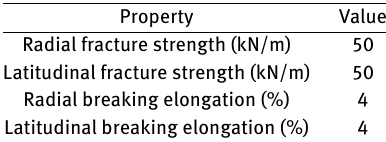
Table 6: Glass fiber grille properties